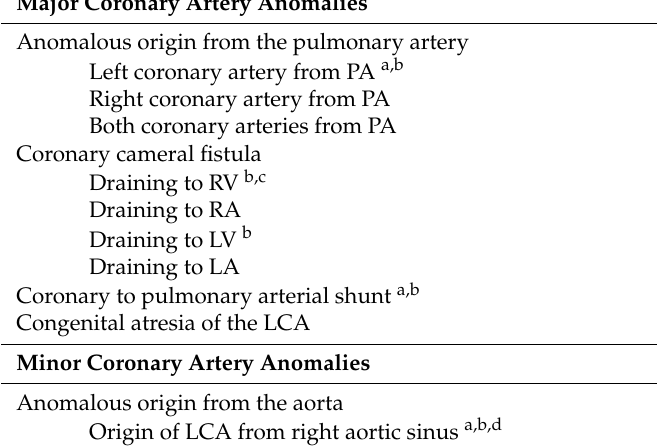
Table 1. Categorization of congenital coronary artery anomalies; modified Dodge-Khatami et al.